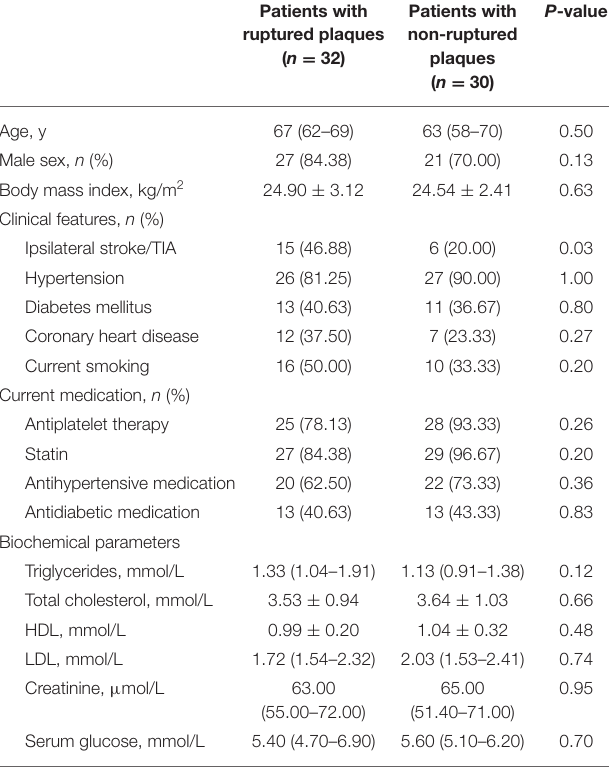
TABLE 1 | Patient